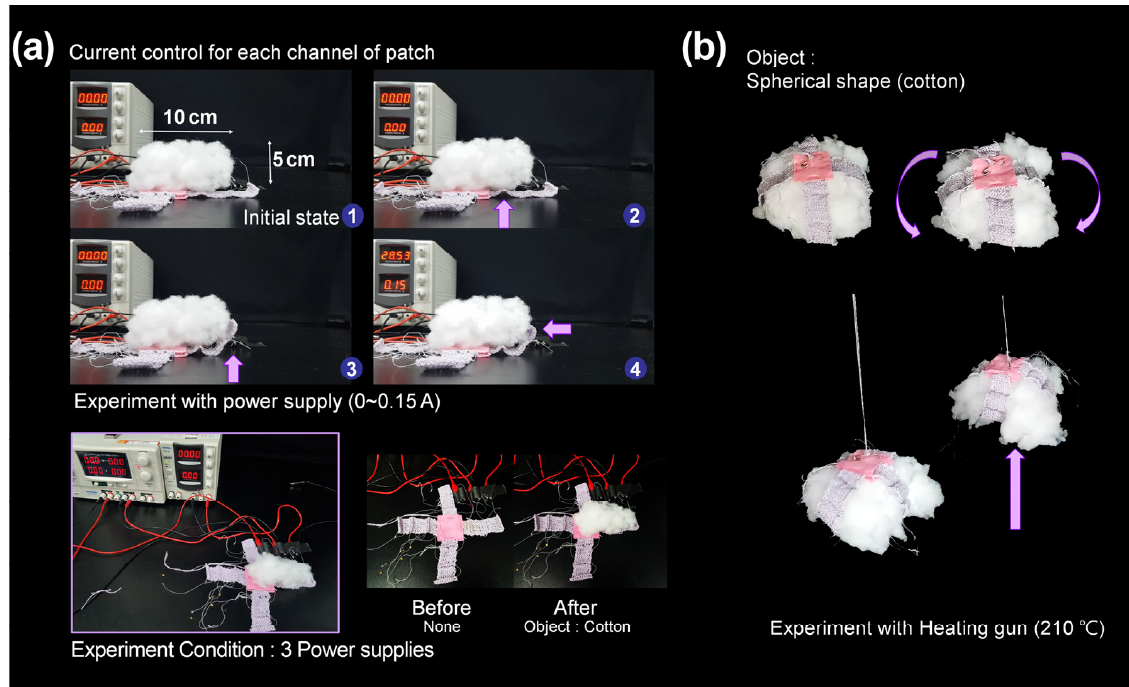
Figure 10. ( a ) Current control for each channel of textile actuators. ( b ) A bulky-shaped piece of cotton is gripped and lifted by the textile gripper.